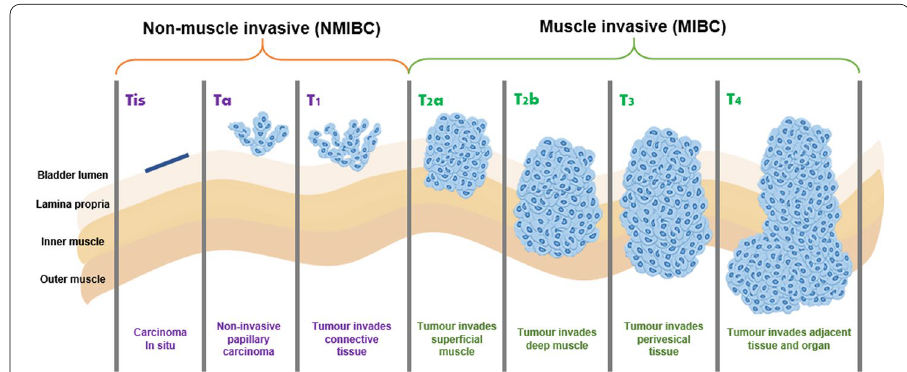
Fig. 1 The classification of stages in diagnosing bladder cancer into non-muscle invasive bladder cancer (NMIBC) and muscle invasive bladder cancer